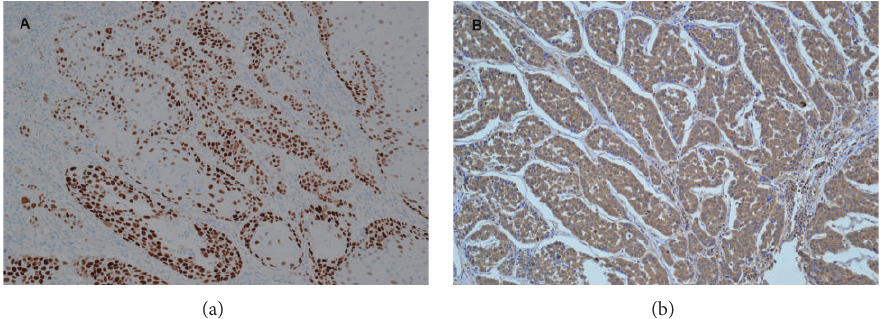
Figure 1: (a) In situ hybridization signal of HPV-positive esophageal squamous cell carcinomas. Numerous tumor cells show positive nuclear signals.(b)Immunohistochemicalstainingofp16 INK4A inesophagealsquamouscellcarcinomas.Morethan50%oftumorcellsshowingstrong nuclear and cytoplasm immunolabeling. (Original magnification × 200.)